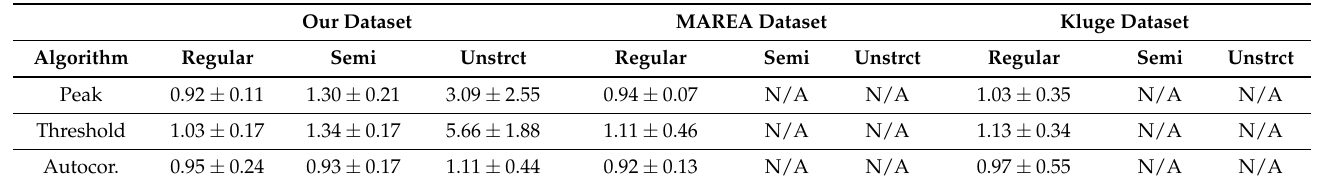
Figure 9. Examples demonstrating decreased accuracy during semi-regular and unstructured gait. Blue lines represent ground truth steps. Green lines represent true positives. Red lines represent false positives. In regular gait, all steps are detected with zero false positives, while in semi-regular and unstructured gait there is a large number of false positives. Table 4. The Running Count Accuracy (accuracy ± standard deviation per participant) of three algorithm types (peak detector, threshold-crossing, and autocorrelation) across three gait types (regular, semi-regular, and unstructured) and three datasets (ours, MAREA, Kluge). Standard deviation across subjects is